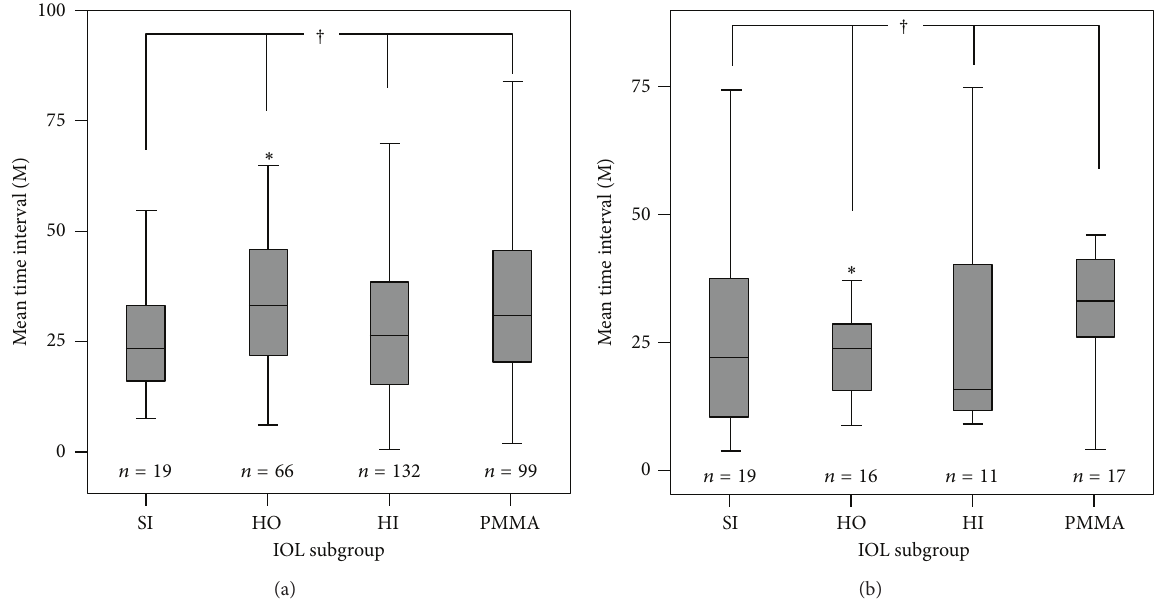
Figure 2: Comparisons of mean time intervals from cataract surgery to Nd:YAG capsulotomy within IOL subgroups. (a) Means comparison of IOL subgroup in the CV group, and (b) means the comparison of the CA group. Within the CV and CA groups, the IOL subgroup showed no difference in the mean time interval to Nd:YAG capsulotomy ( 𝑃 = 0.838 and 0.066, resp.). However, the hydrophobic acrylic IOL subgroup within the CV group showed a significantly earlier time to Nd:YAG capsulotomy than that of the CA group ( 𝑃 = 0.028 ). SI, HO, HI, and PMMA refer to silicone, hydrophobic acrylic, hydrophilic acrylic, and polymethyl methacrylate IOL materials, respectively. The asterisk indicates a statistical difference of the mean time interval to capsulotomy between the hydrophobic acrylic IOL subgroups of CV and CA. The cross indicates no difference in the mean time interval of capsulotomy within the IOL